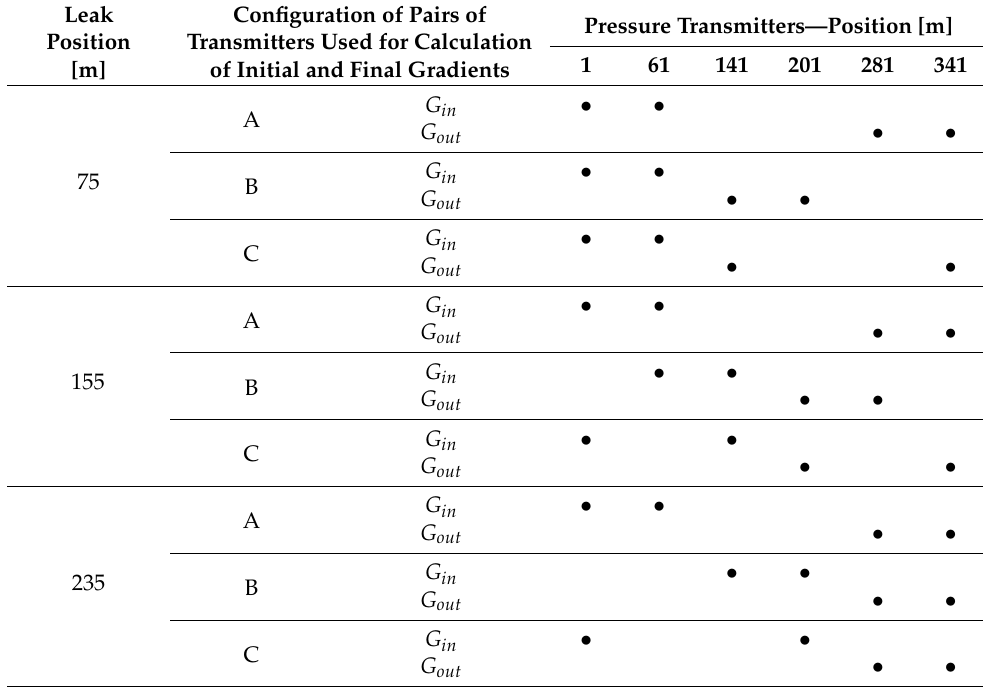
Table 1. Configurations of the pressure transmitters used for leak localization in conjunction with the pressure transmitters and the leak point positions. G in shows the position of the initial sensor pair (upstream from the leak point), while G out is the position of the final pair (downstream from the leak point), used in the gradient leak localization procedure in the carried out experiments and chosen depending on the coordinate of a simulated leak’s